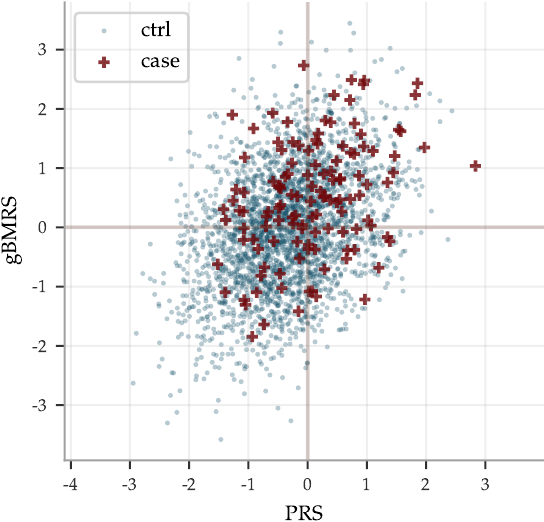
Figure 9. Risk scores predicted from SNPs PRS and from PGS of biomarkers gBMRS do not always agree, here exemplified by type 2 diabetes data for men. Both predictors predict case status directly from SNPs alone. Their outputs correlate ∼ 0.37 with a linear regression coefficient of ∼ 0.39. In the noise, they capture some complementary information: the sum of the risk scores achieves an AUC of ∼ 0.67 while the gBMRS and PRS predictors individually achieve AUCs of ∼ 0.63 and ∼ 0.64, respectively.